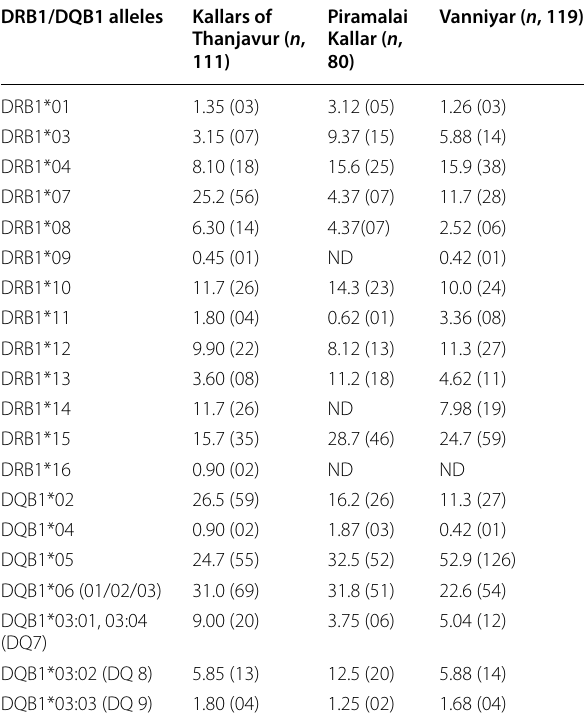
Table 1 Frequencies of HLA-DRB1 and -DQB1 alleles in